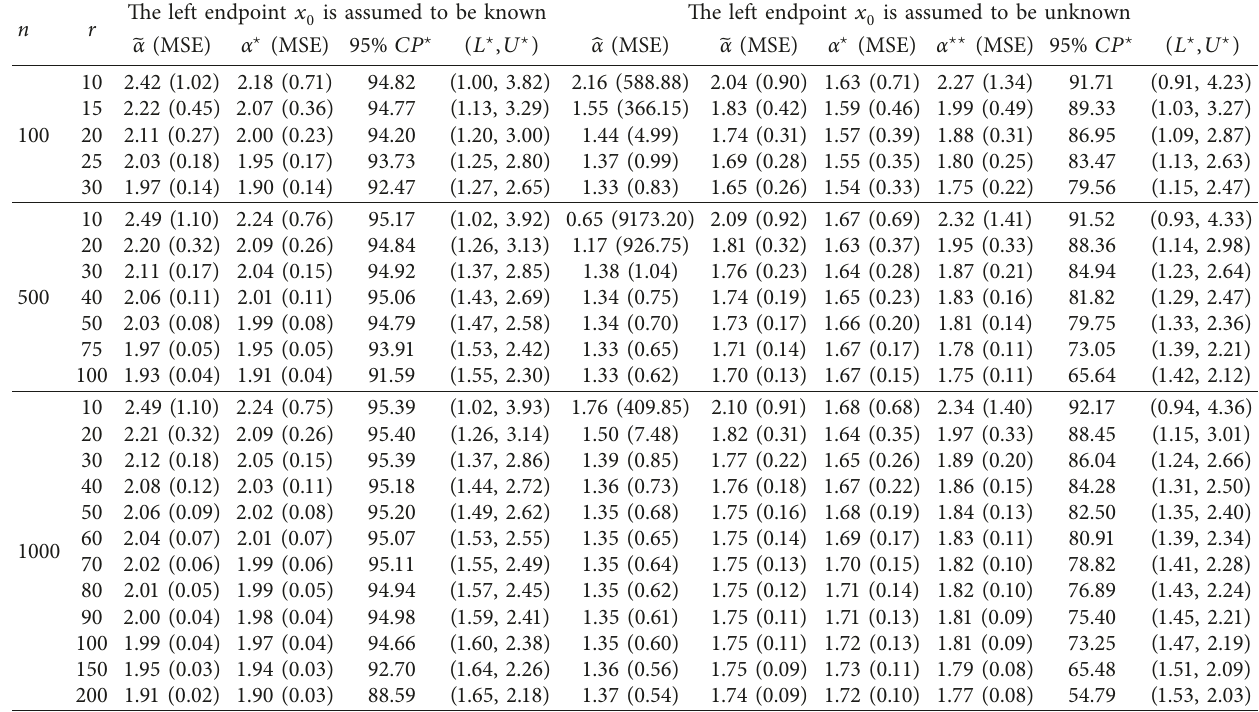
, ... , X r : n for different values 1 : n ) . 2 is assumed to be unknown 0